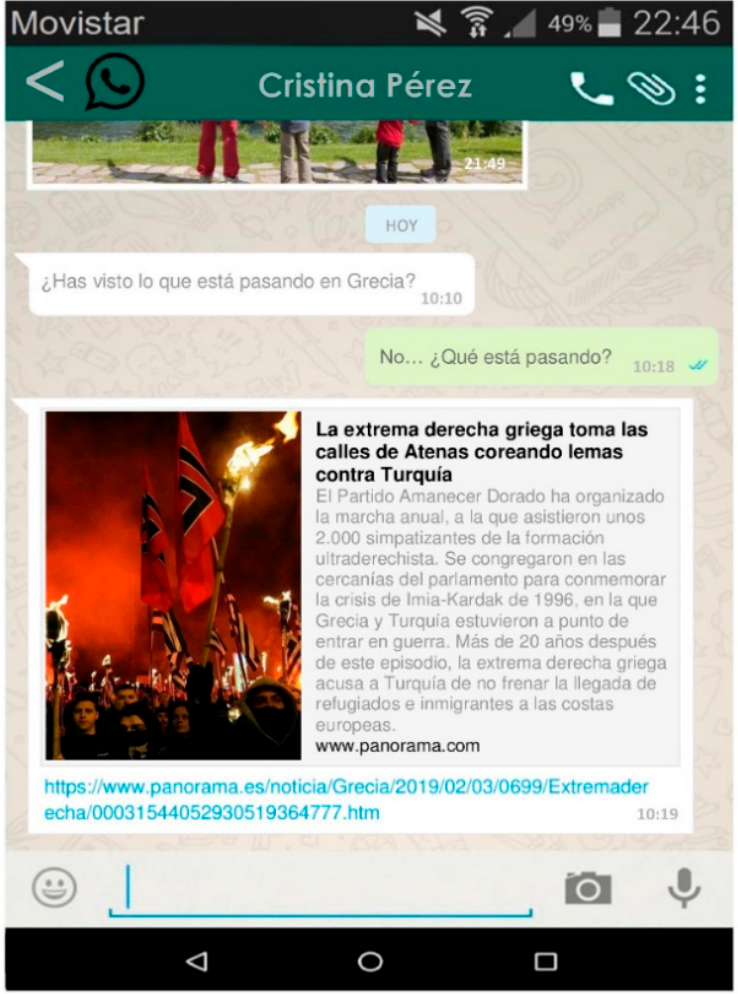
Figure A4. Sample of the news item on the far right in WhatsApp Figure A4 . Sample of the news item on the far right in WhatsApp format